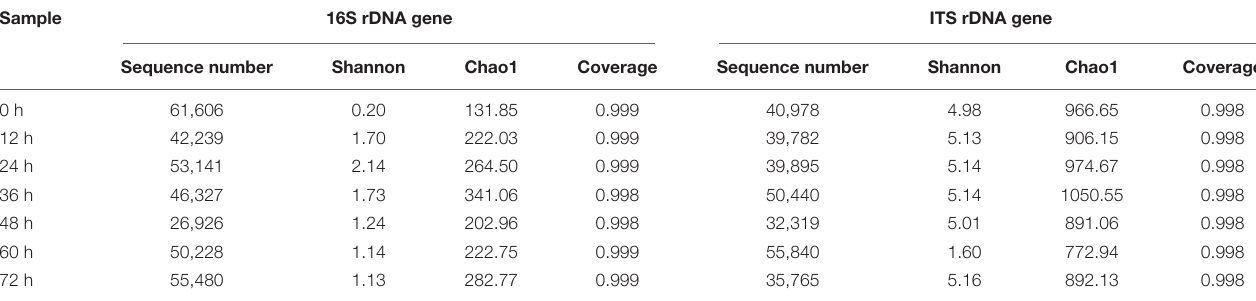
TABLE 3 | Sequence number and alpha diversity indices of bacterial and fungal community of the non-post fermented Shuidouchi samples. Sample 16S rDNA gene